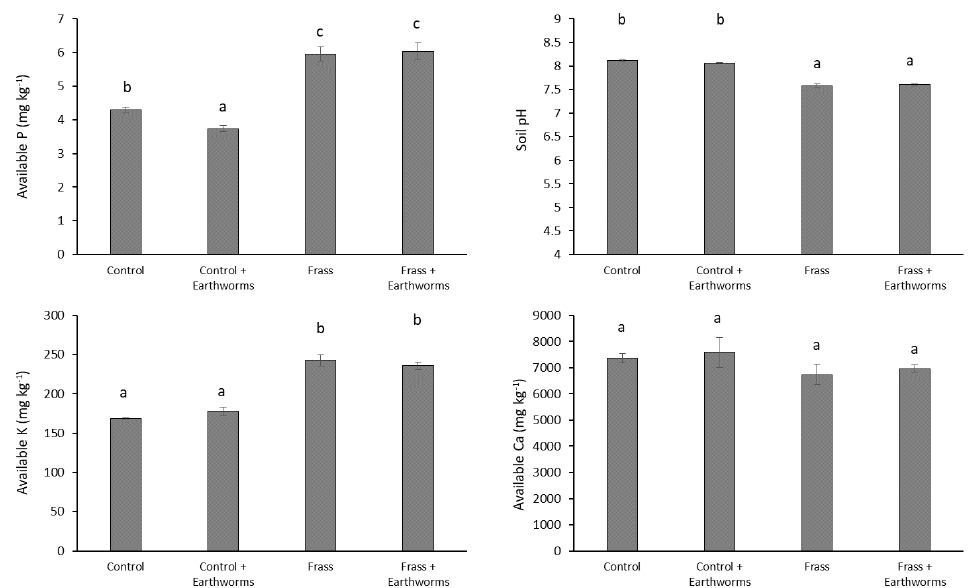
Figure 3. Available P concentration (water extraction), available K and Ca concentrations (AA-EDTA extraction), and pH in the soil. Values are average (n = 4) ± standard error. Columns with the same letter do not differ significantly at the 5% level.